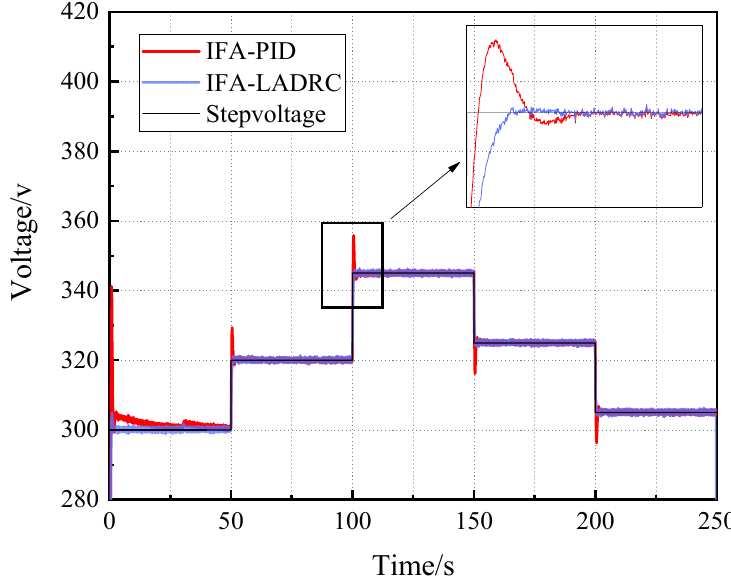
Figure 10. Voltage rise and fall response curves under different controllers.